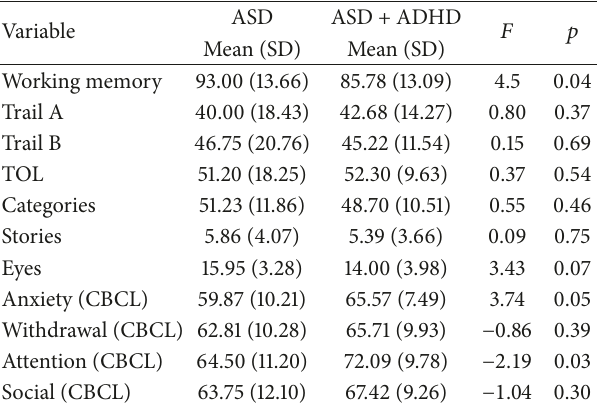
Table 2: Means and standard deviations for the experimental